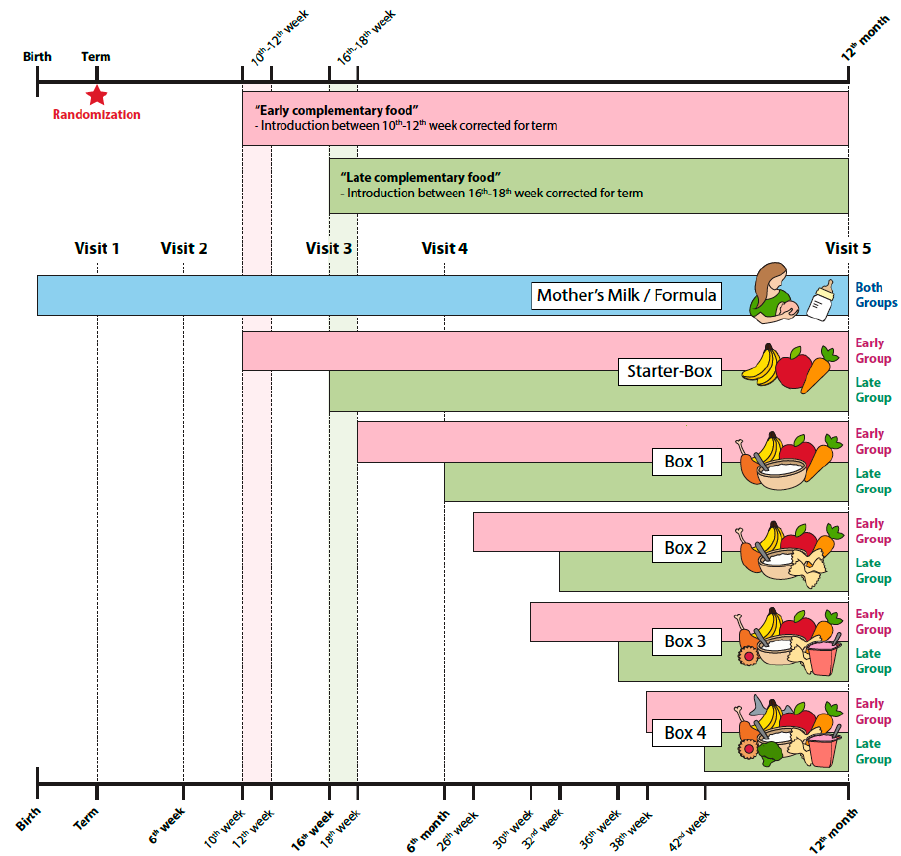
Figure 2. Study flow chart. This figure shows the timeline for randomization, study visits, and the introduction time points of complementary food for early and late study group. The content of feeding boxes is represented by symbols for nutrient groups. feeding boxes is represented by symbols for nutrient